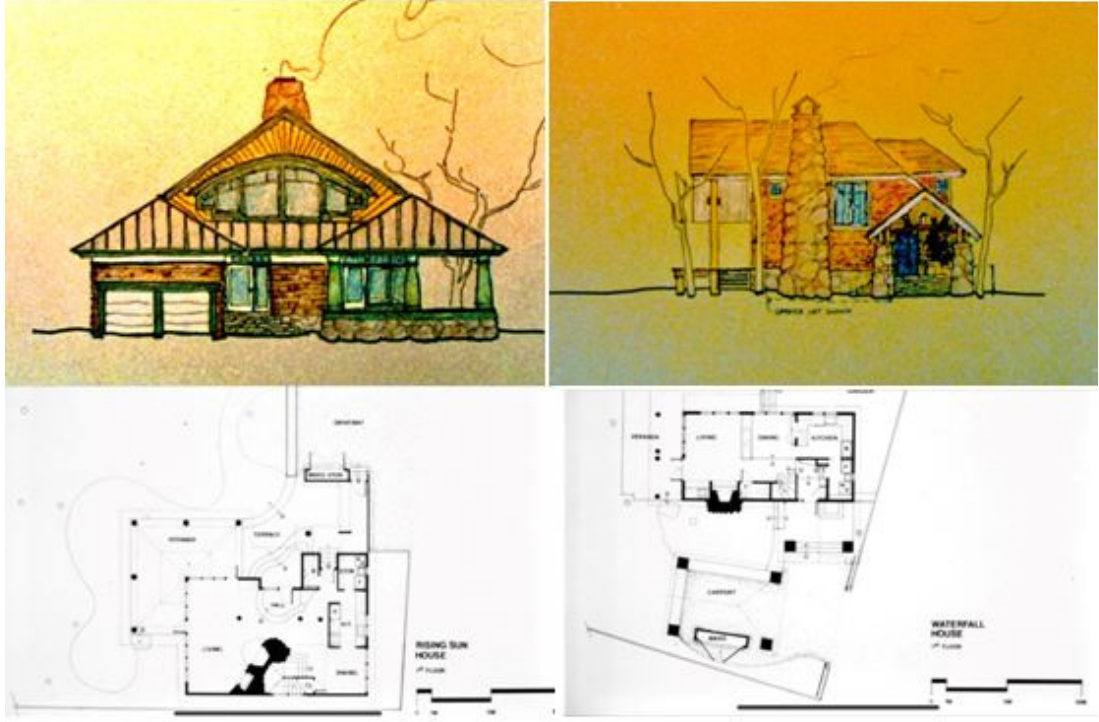
Figure 2. These home designs reflected the client expressed joy at making "happy" architecture.